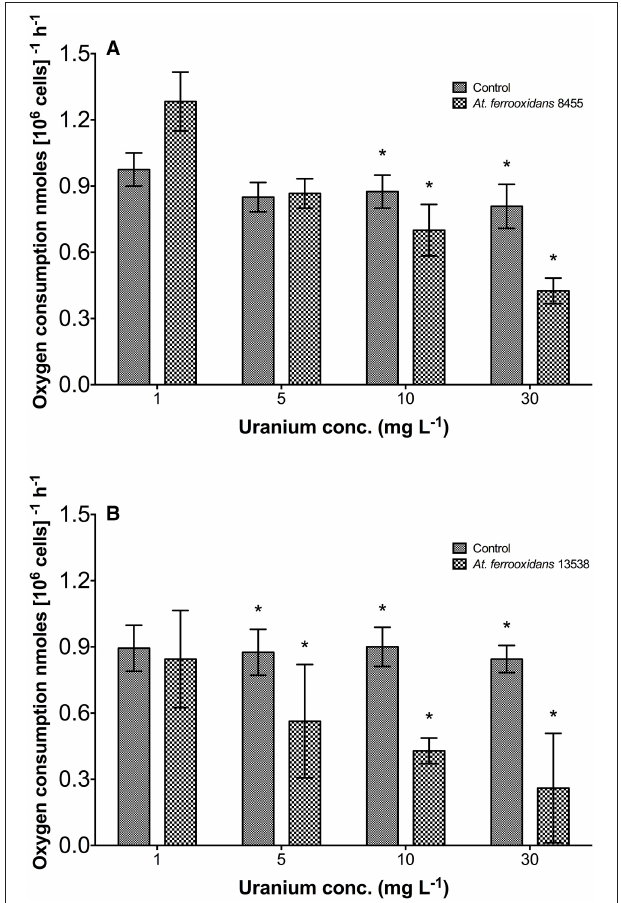
FIGURE 3 | Oxygen consumption rate by At. ferrooxidans 8455 (A) and 13538 (B) as a function of increasing concentration of U(VI) in solution. The respiration rate is inhibited by the increasing concentration of U(VI) in solution up to 30mg (VI) L − 1 . Data labeled with * indicate significantly different